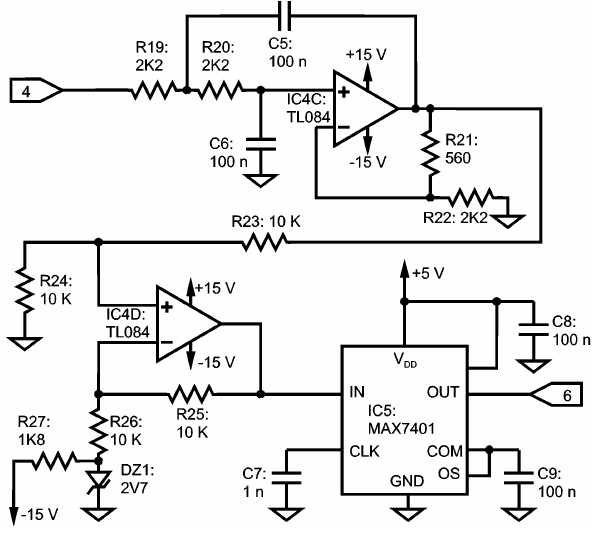
Figure 8. Anti-aliasing low-pass Bessel filters: continuous and switched capacitor